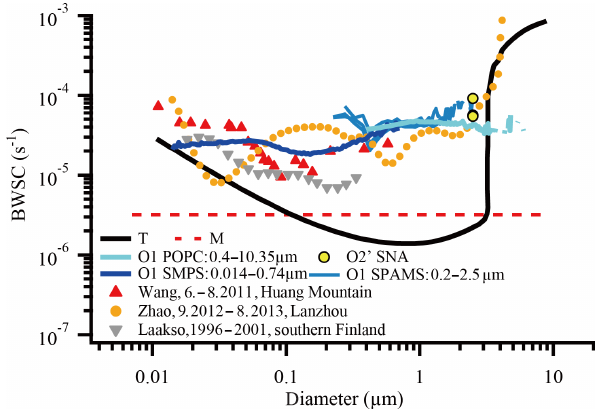
Figure 2. Time series of particle number size distributions (a) measured by POPC, SPAMS (take SO 2 − The averaged spectrum distribution of number concentration during the APHH-Beijing campaign (a) for SMPS (purple line); POPC (green line); and NO − (blue line), SO 2 − (red line), and NH + (orange line) by SPAMS. 3 4 4